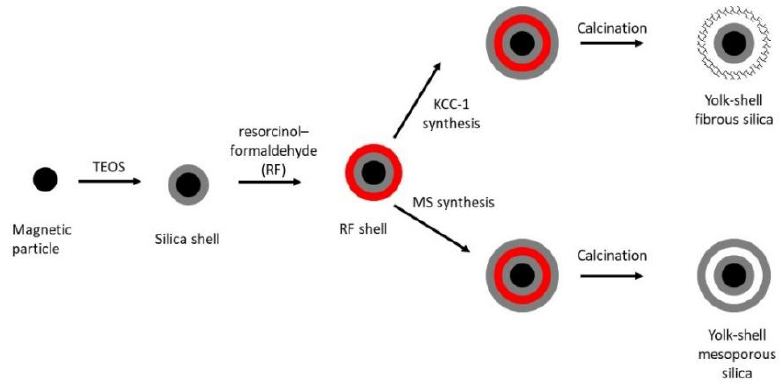
Figure 11. Synthesis of yolk–shell hollow fibrous and non-fibrous microspheres. The same research group [118] covalently immobilized lipase from Candida rugosa on